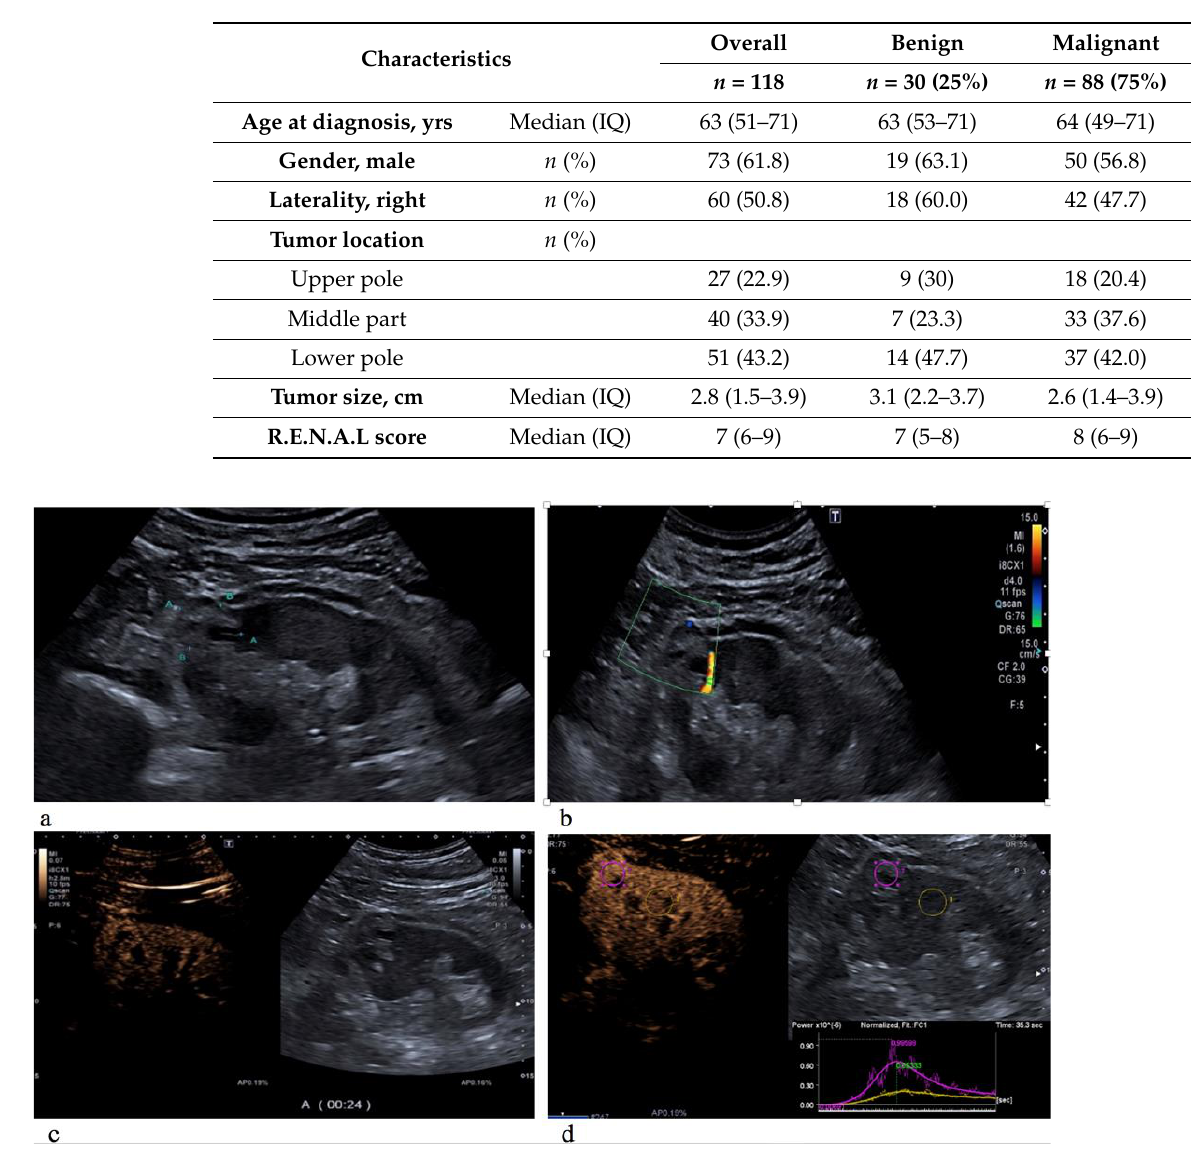
Figure 1. Clear cell carcinoma on the upper pole of the left kidney, characterized by an inhomogeneous hyperechoic echotexture with fluid-filled lacuna ( a ); on color Doppler US evaluation, it appeared with poor peripheral vascularization ( b ); and on CEUS evaluation, the lesion showed rapid and inhomogeneous enhancement compared to the normal renal cortex parenchyma ( c ). As showed by the time-intensity curve ( d ), the renal mass has a higher peak of the signal intensity (PI) and an incremented regional blood volume (RBV) in comparison to the surrounding healthy parenchyma. Table 2. Histopathological characteristics.